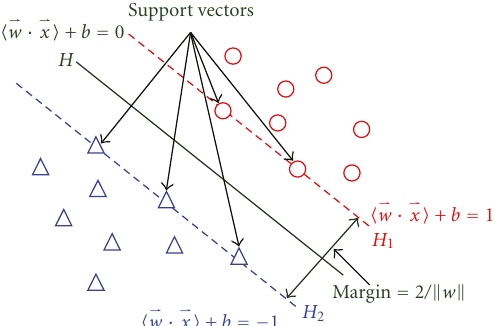
Figure 1: Fundamental idea of OSH and